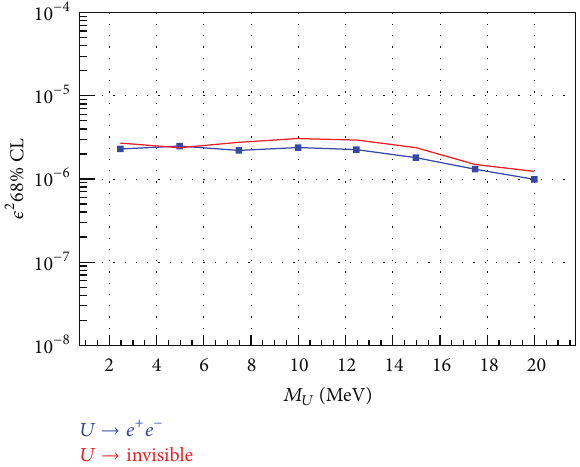
Figure 18: Acceptance for 𝑈 boson detection as a function of its mass.